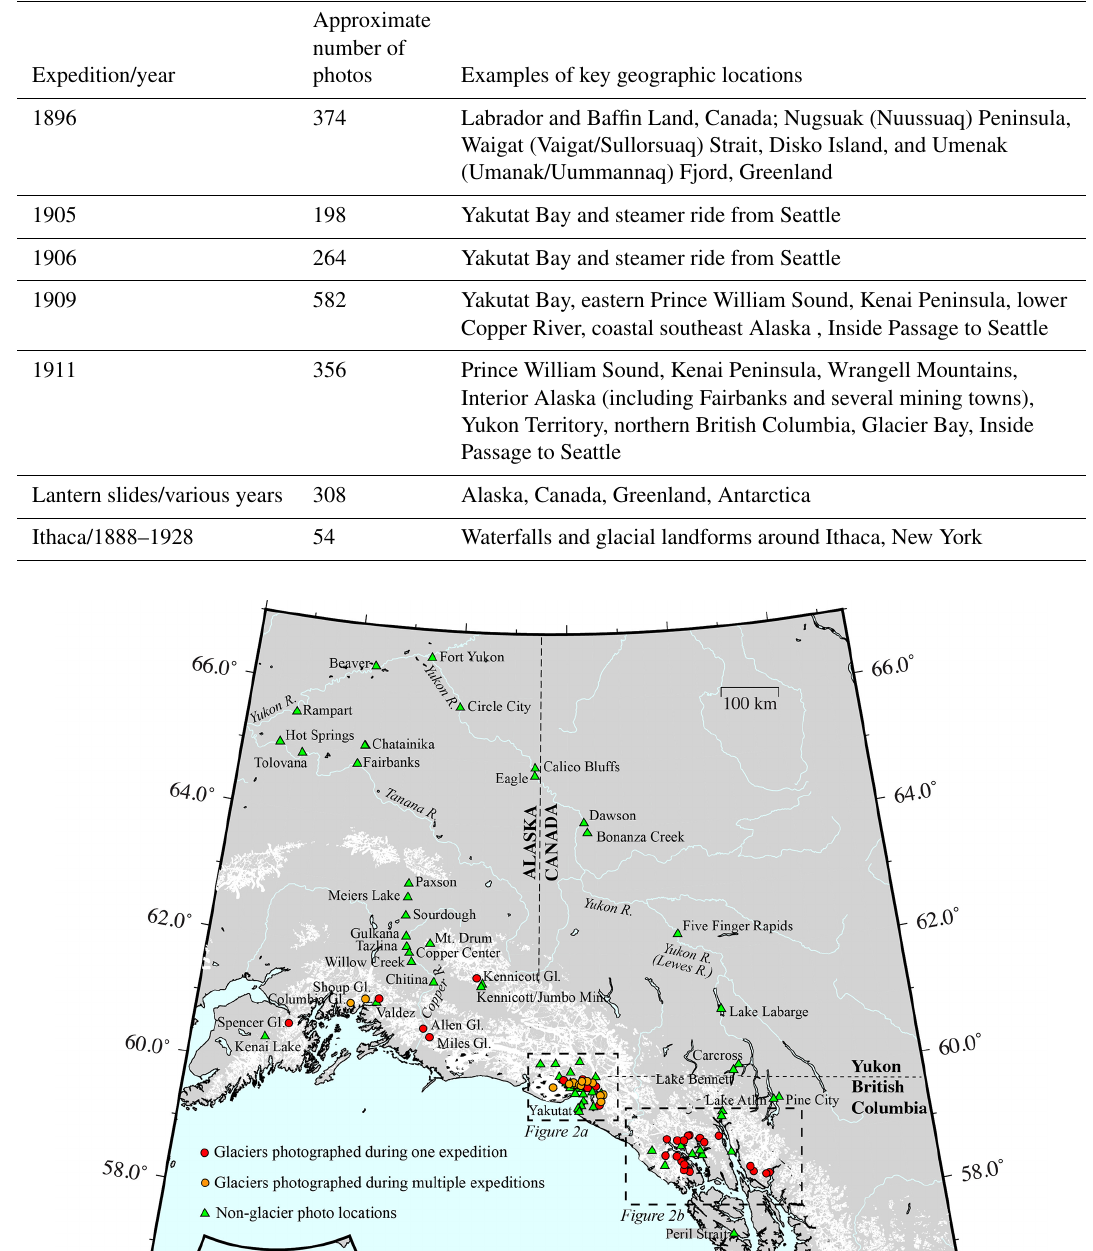
Table 1. Summary of digitized photographs.